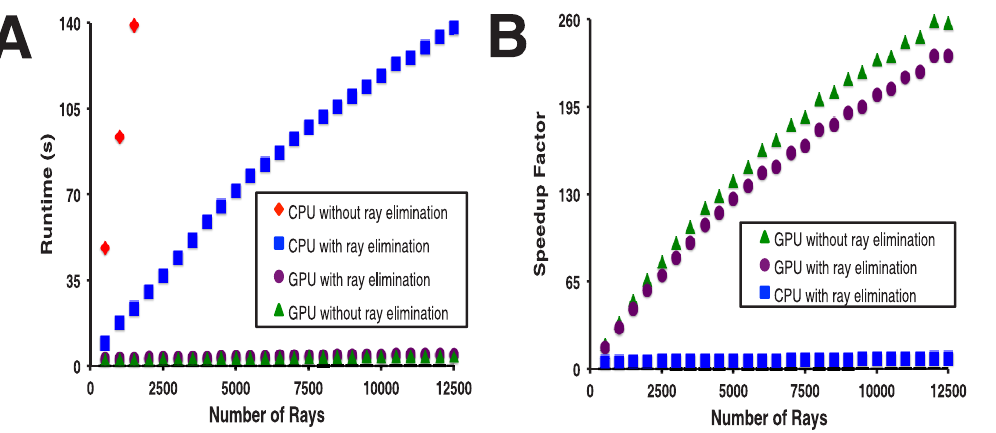
Figure 7. Comparison of DARC optimization with and without the ‘‘ray elimination’’ step. The ‘‘ray elimination’’ step is found to significantly improve performance of DARC on the CPU alone, but made little difference when the GPU is used. A ) Time required to complete the optimization, using a CPU alone or with the GPU. B ) Speedup factor, reported as the ratio of the time required using the GPU to the time required using the CPU